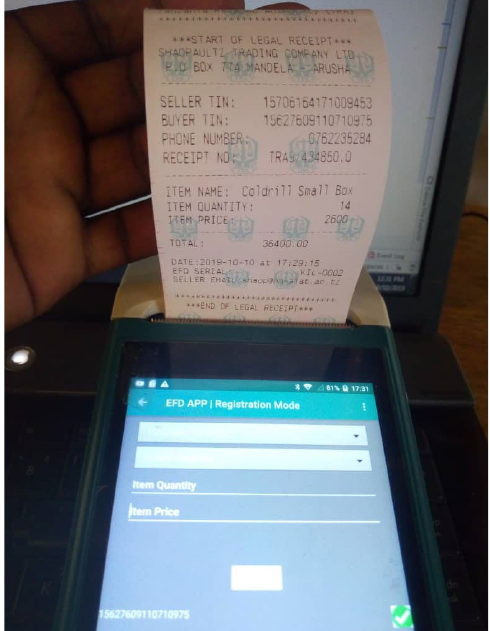
Figure 7. Physical receipt issued to customer